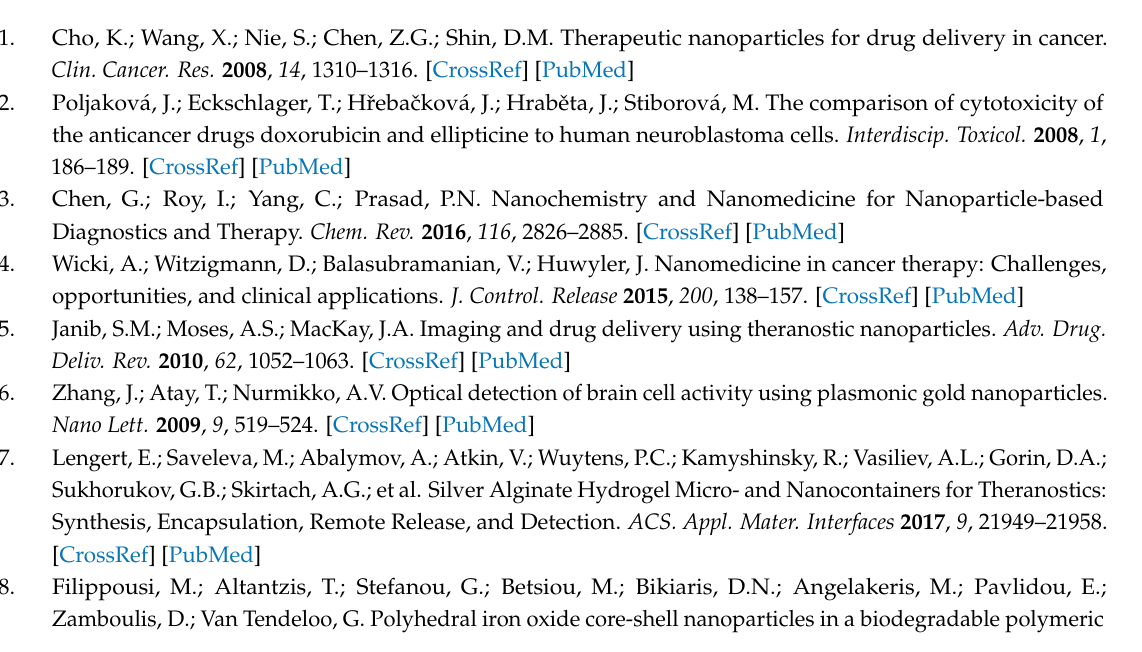
Figure S1: TGA curves of UiO-66_N (blue line) and UiO-66_N@Acr (orange line); Figure S2: Size distribution of UiO-66_N obtained by direct synthesis; Figure S3: UV-vis spectra in simulated body fluids (SBF) of acridine orange (orange line), UiO-66_N@Acr (red line) and SBF surnatant after 24 h and 48 h; Figure S4: Calcium channels activation in untreated cells; Figure S5: Calcium channels activation during treatment with UiO-66_N; Figure S6: Wound healing assay of U251 cells; Figure S7: High magnification FE-SEM image of UiO-66_N. Author Contributions: Conceptualization, C.A., S.B., S.G., R.D., and F.C.; Data curation, S.B., S.G., O.B. and